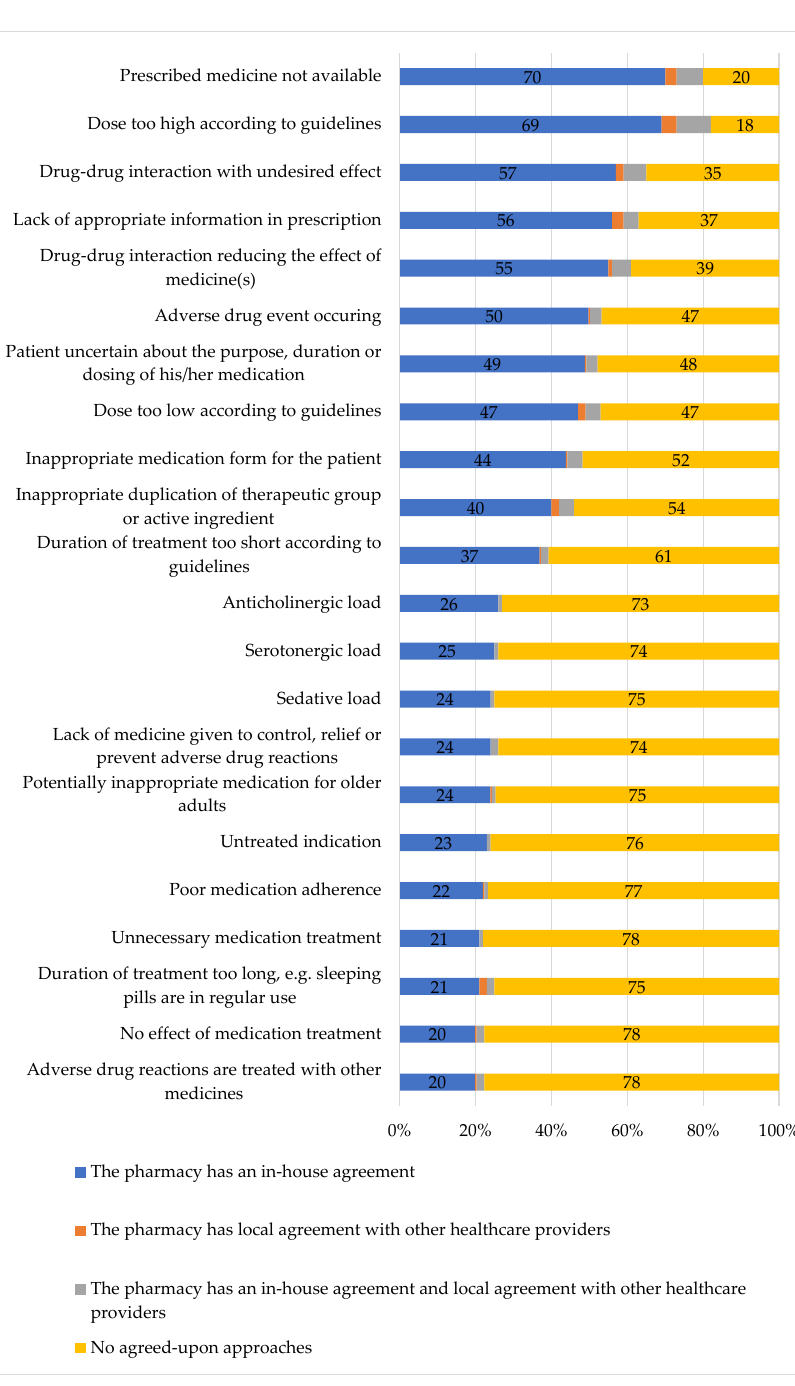
Figure 2. In-house and local agreements for managing medication-related risks in community pharmacies (% of the responding pharmacies, n = 169. The responses that were given by less than 10 per cent of respondents have not been